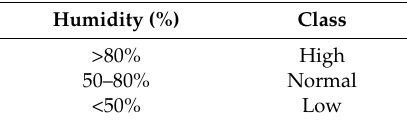
Table 6. Classes of humidity.